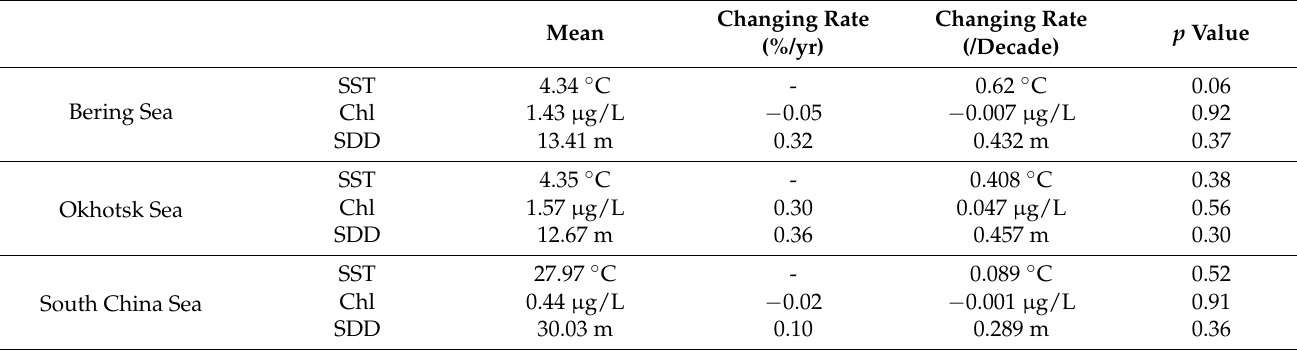
Table 1. Temporal changing rate and statistics of SST, Chl, and SDD during 1998–2018.